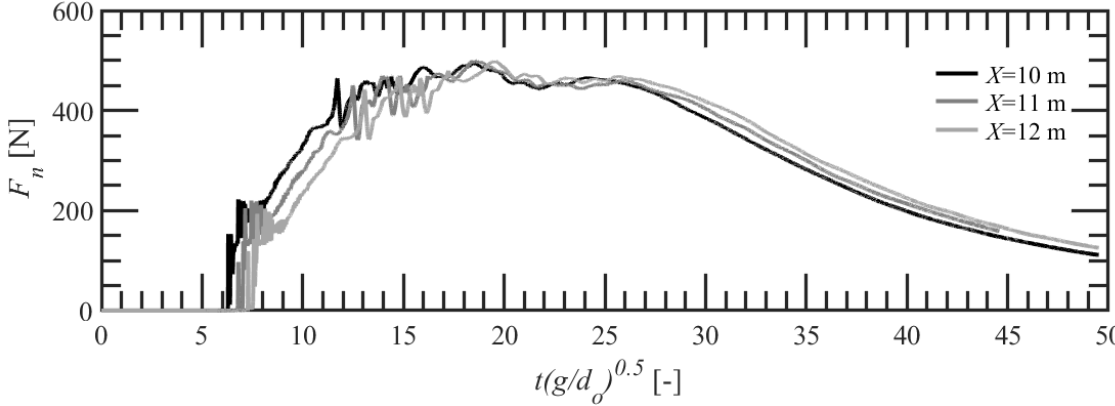
Figure 9. Force time history for d o = 0.9 m at three locations.